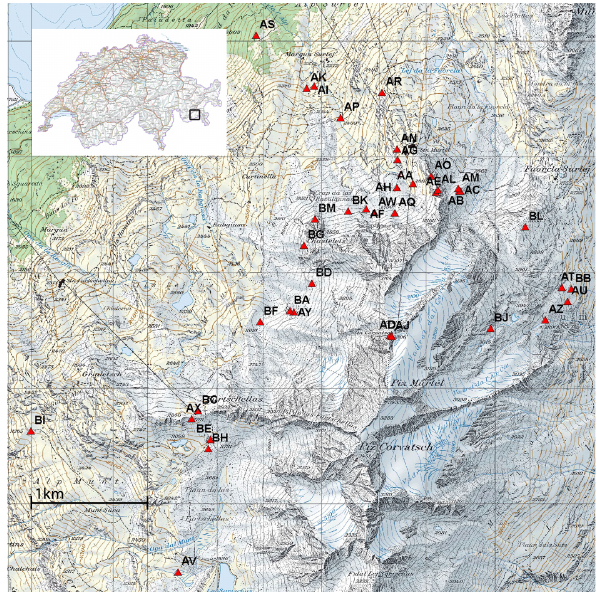
Fig. 1. Locations of the 39 footprints at Corvatsch study site. Reproduced by permission of swisstopo (BA110077).